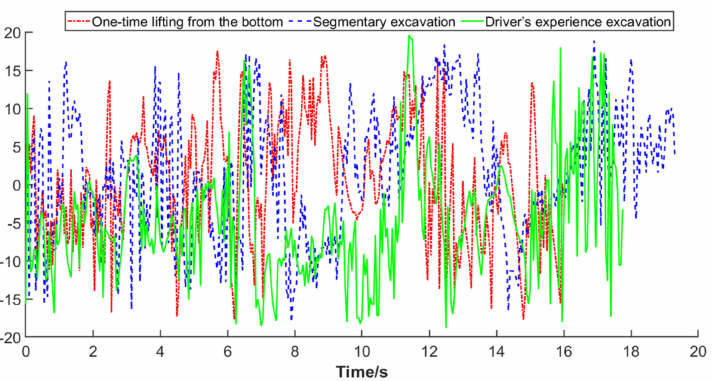
Figure 12. The working resistance error curves between test and simulation under different trajectories. Table 3. Data comparison of working resistance between simulation and